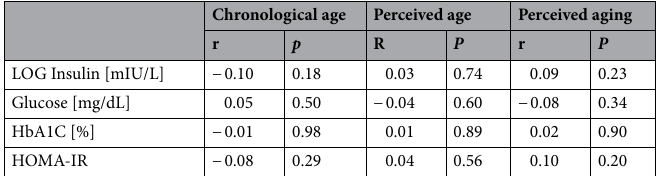
Table 4. The relationship between glycemic markers and perceived age in women (N = 163).